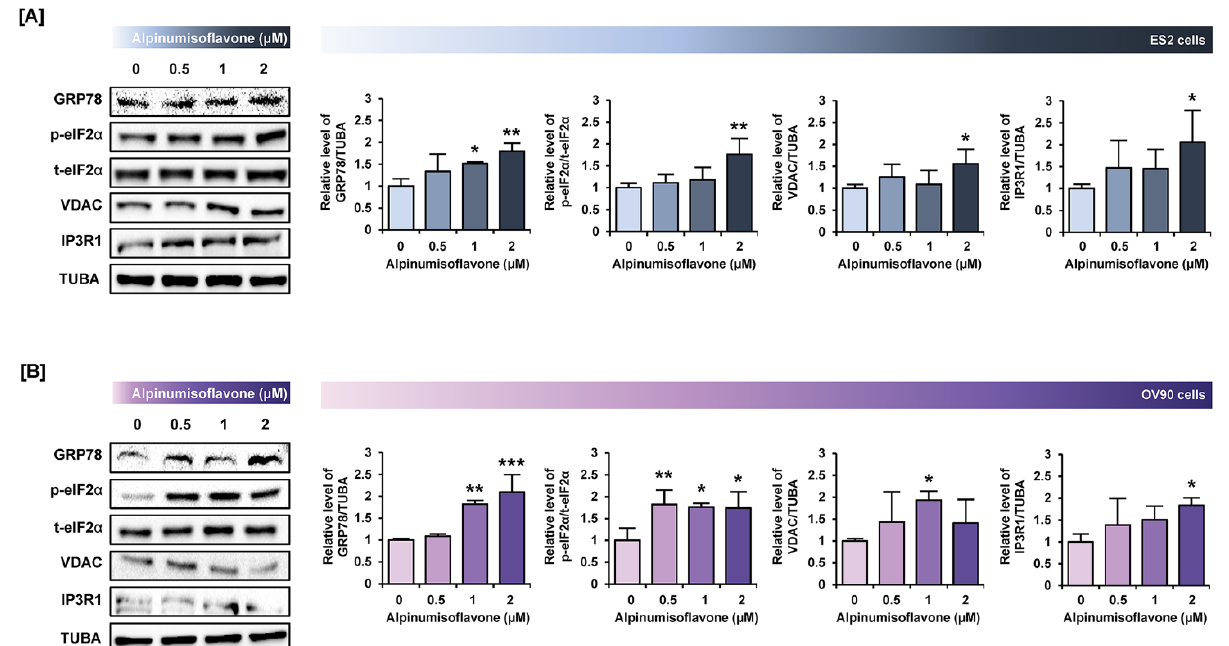
Figure 7. Alpinumisoflavone activates the ER stress and ER – mitochondria contact proteins in ES2 and OV90 cells. ( A , B ) In both ES2 ( A ) and OV90 ( B ) cells treated with alpinumisoflavone for 24 h, immunoblots of GRP78, phosphor- eIF2α, total- eIF2α, VDAC, IP3R1 and TUBA were captured using the ChemiDoc system. Relative intensities of each target protein are presented as bar graphs next to sorted immunoblots. All experiments were performed in triplicate. The significance between the vehicle and treatment groups is depicted by asterisks (* p < 0.05, ** p < 0.01 and *** p < 0.001).